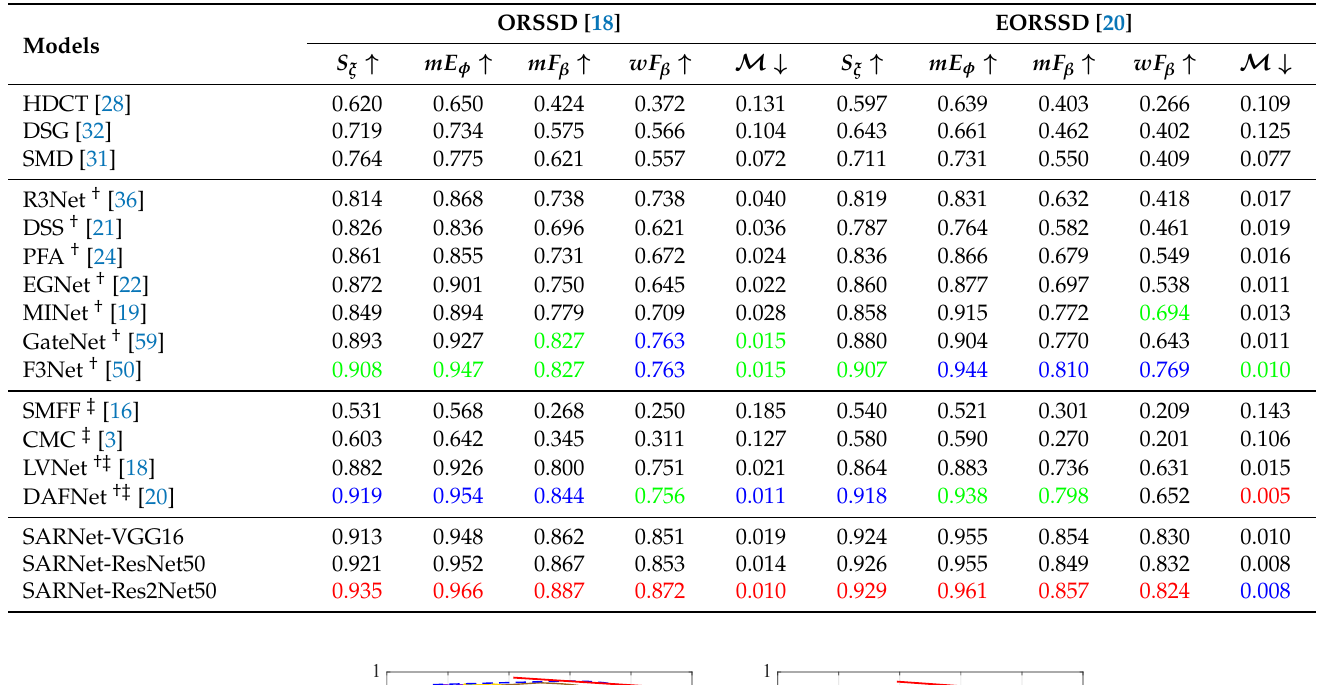
Table 1. Comparison with the SOTAs. The top three of our one and the other methods are highlighted in red, blue, and green. ↑ and ↓ denote larger and smaller scores are better, respectively. † and ‡ denote CNN-based and RSI-based SOD methods, respectively.